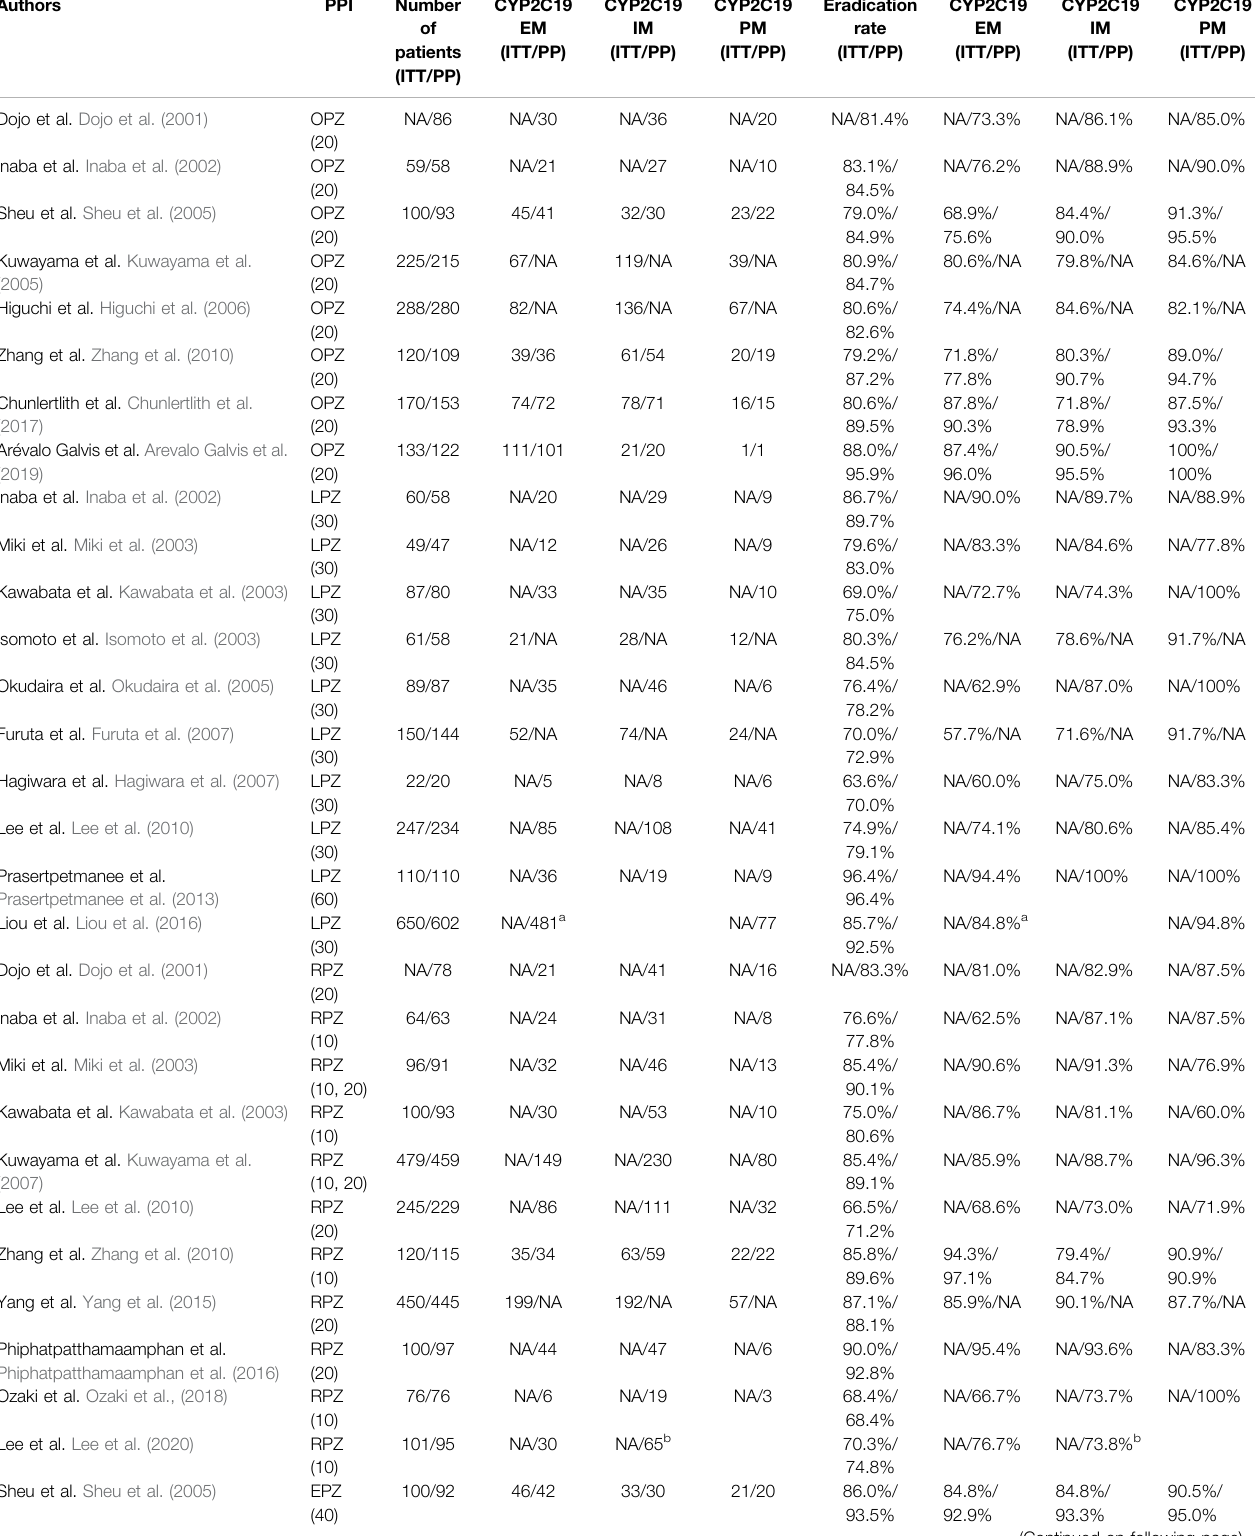
TABLE 3 | Studies that investigated H. pylori eradication outcome among CYP2C19